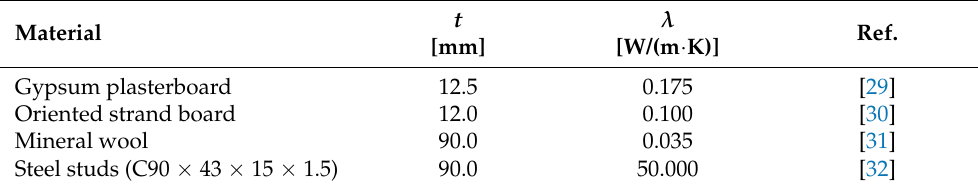
Table 2. Characterization of the materials used in the partition LSF walls: thicknesses ( t ) and thermal conductivities ( λ